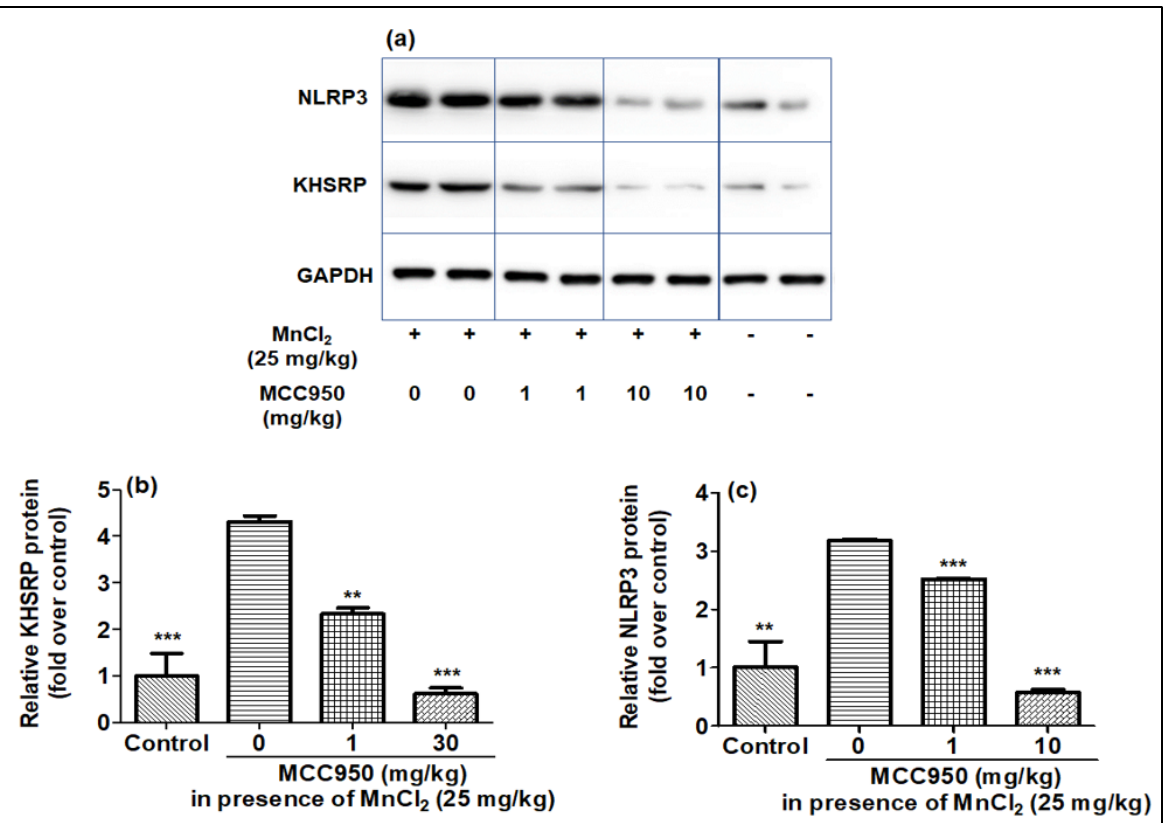
Figure 8. MnCl 2 was able to overexpress the KHSRP and NLRP3 mRNA expression, which was controlled in a dose-dependent manner by MCC950 in rat brain samples detected by qPCR. ( a ) rel- ative KHSRP mRNA expression, ( b ) relative NLRP3 mRNA expression. All mRNA values were normalized to the housekeeping mRNA, GAPDH, and expressed as a fold-induction over the con- trol sample (set at a value of 1). Data represented as mean ± SEM. * p < 0.05, ** p < 0.001, *** p < 0.0001 vs. control group.